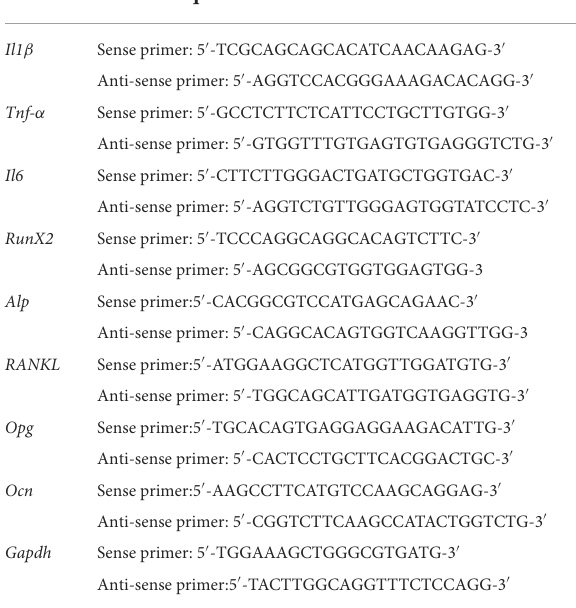
TABLE 1 Primer sequences for amplification of mouse